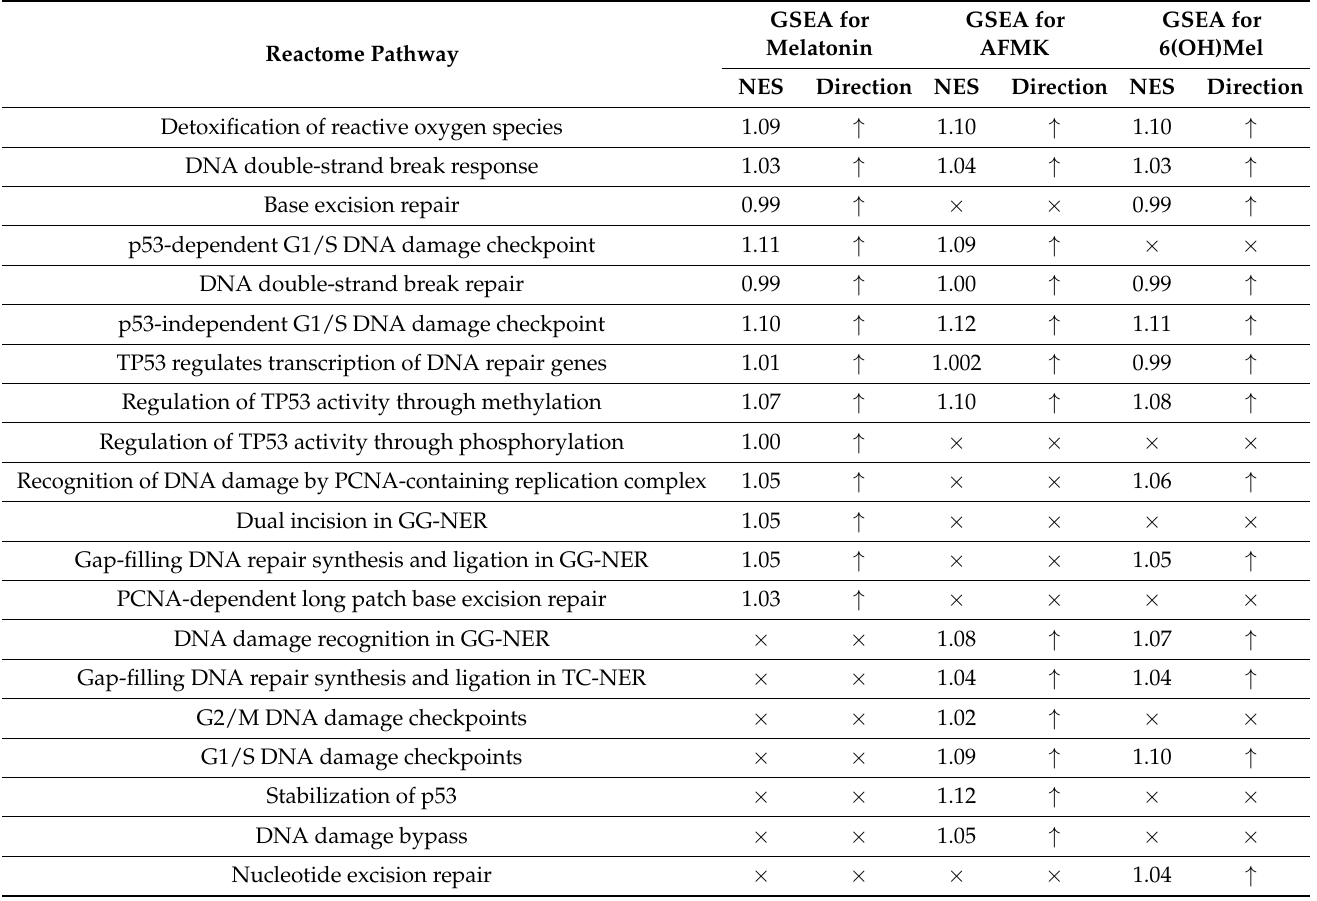
Table 2. Gene Set Enrichment Analysis (GSEA) results for oxidative stress and DNA damage response gene sets affected by melatonin, AFMK and 6-hydroxymelatonin (6(OH)Mel) in human epidermal keratinocytes; NES—Normalized Enriched Score; ( × )—the effect is